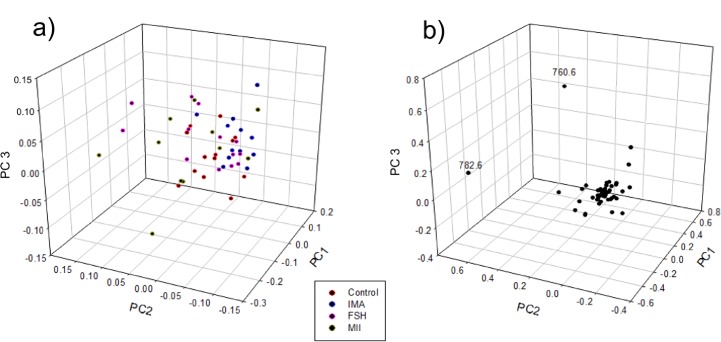
3D PCA plot for MALDI-TOF data of individual oocytes from different maturation systems.Shown is a 3D PCA plot for the MALDI-TOF data of single oocytes. a) Red (n = 12), blue (n = 13), pink (n = 13) and dark yellow (n = 10). Each point indicates the 3D PCA plot of an oocyte based on its phospholipid composition. The following four fresh oocyte experimental groups are represented: immature and in vitro-matured oocytes recovered from slaughter house ovaries (CONT), oocytes obtained by OPU from non-superstimulated females (IMA), superstimulated females (FSH) and in vivo-matured oocytes obtained by OPU from superstimulated females that received an ovulation inducer (MI). b) indicates the main ions represented, 760.6[PC (34:1) + H]+ and 782.6 [PC (34:6) + H]+ or [PC (34:1) + Na]+, are responsible for the most variability between the treatments. The three principal components explain >73% of the variability of the data.